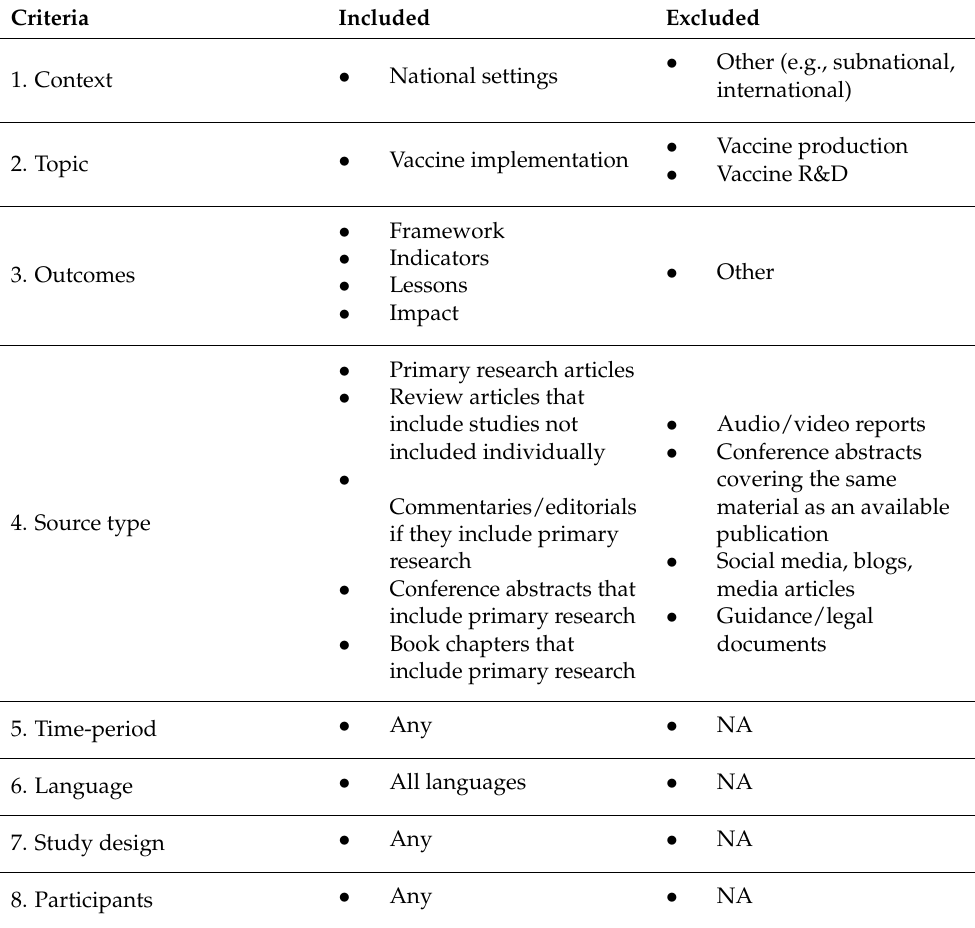
Table 2. Eligibility